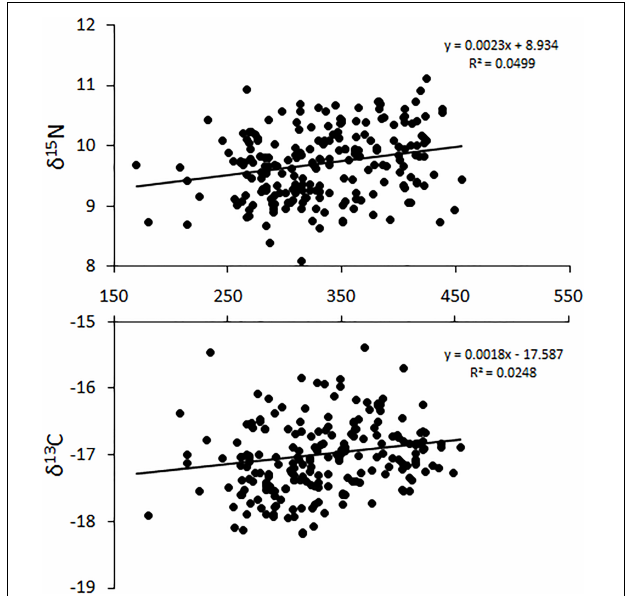
FIGURE 6 | Change in δ 15 N and δ 13 C with increasing total length (TL) for all lionfish captured in Bermuda. Horizontal axis = total length (TL: mm). This relationship is not significant [ANOVA, F (1,126) = 3.91, p > 0.05].